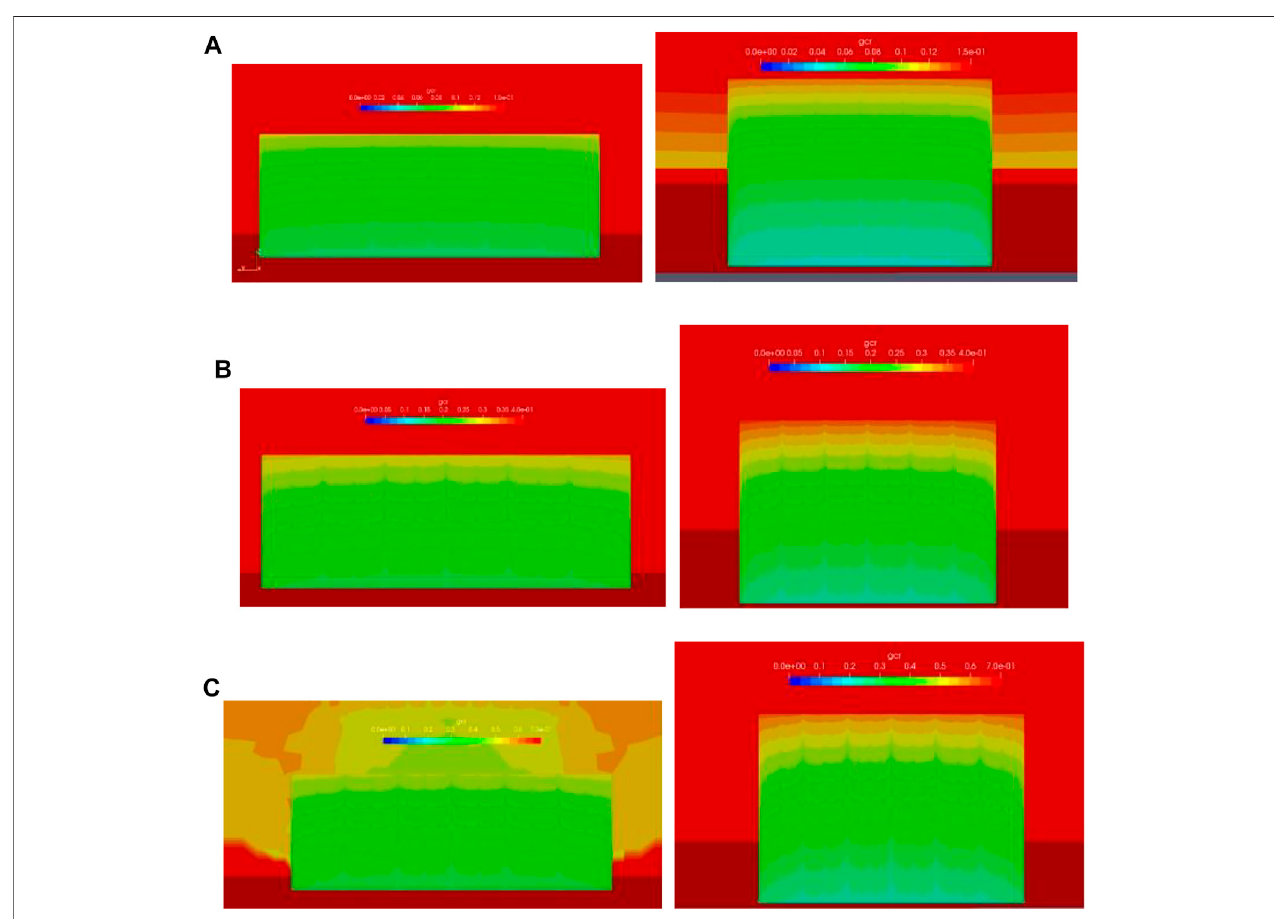
FIGURE 4 | Catch ratio distribution of windward building facades at different reference velocities: (A) U ref (cid:2) 1m/s, (B) U ref (cid:2) 3m/s, and (C) U ref (cid:2) 5m/s.